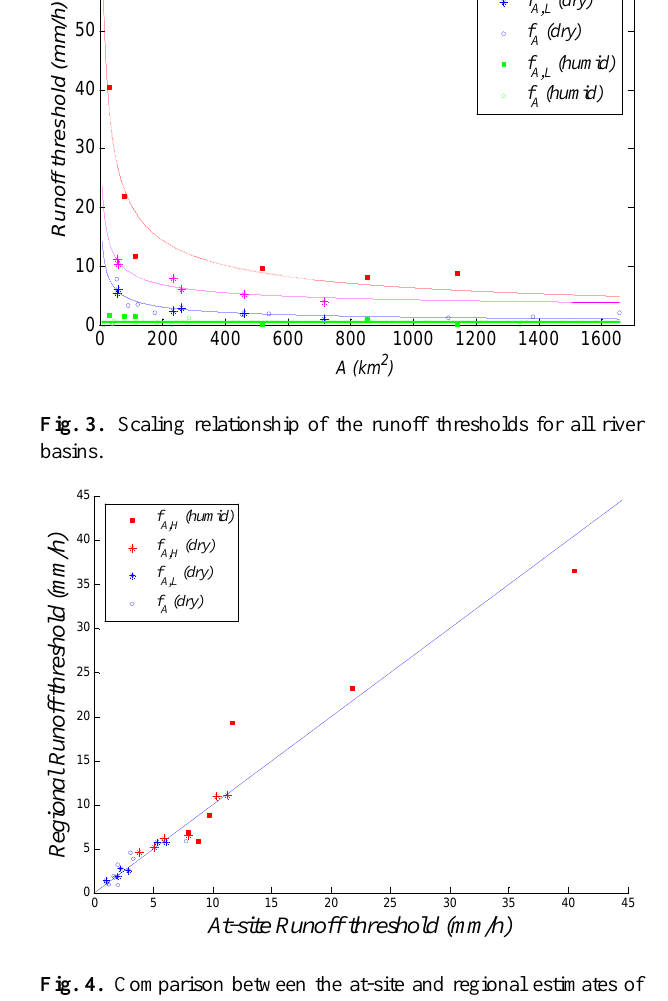
Fig. 4. Comparison between the at-site and regional estimates of different runoff thresholds for all river